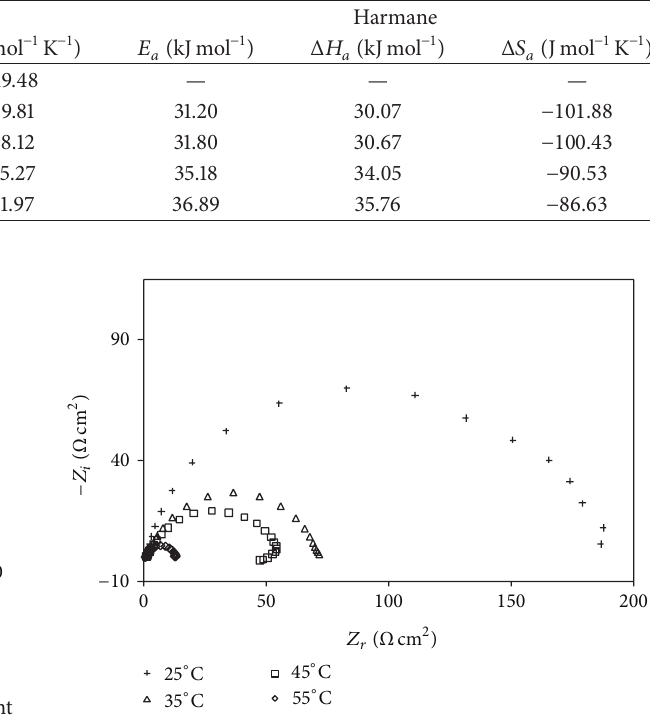
Figure 10: Nyquist diagrams for C38 steel in 1M HCl containing 0.2 mM of harmane at different temperatures.